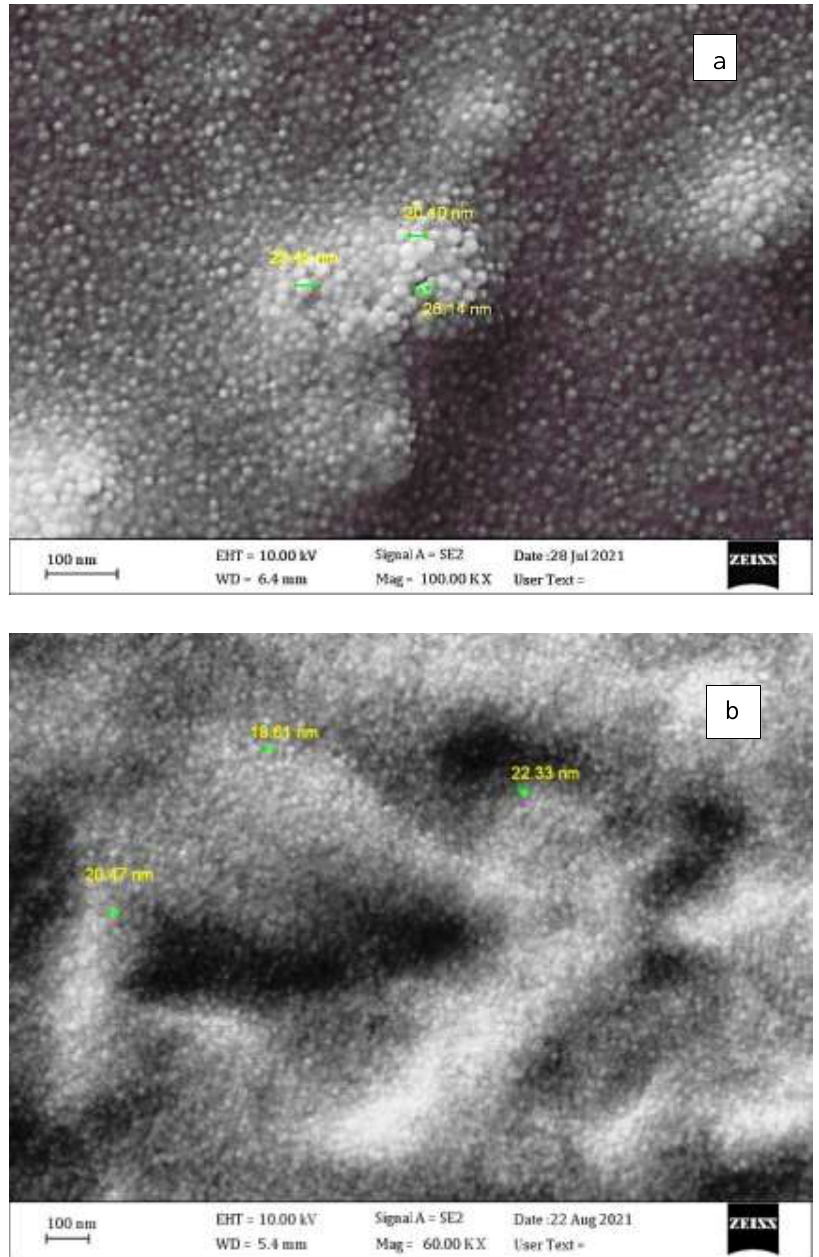
Figure 7: SEM image of liNbO 3 prepared by PLAL using Z-cut wafer target (a) water, (b) ethanol